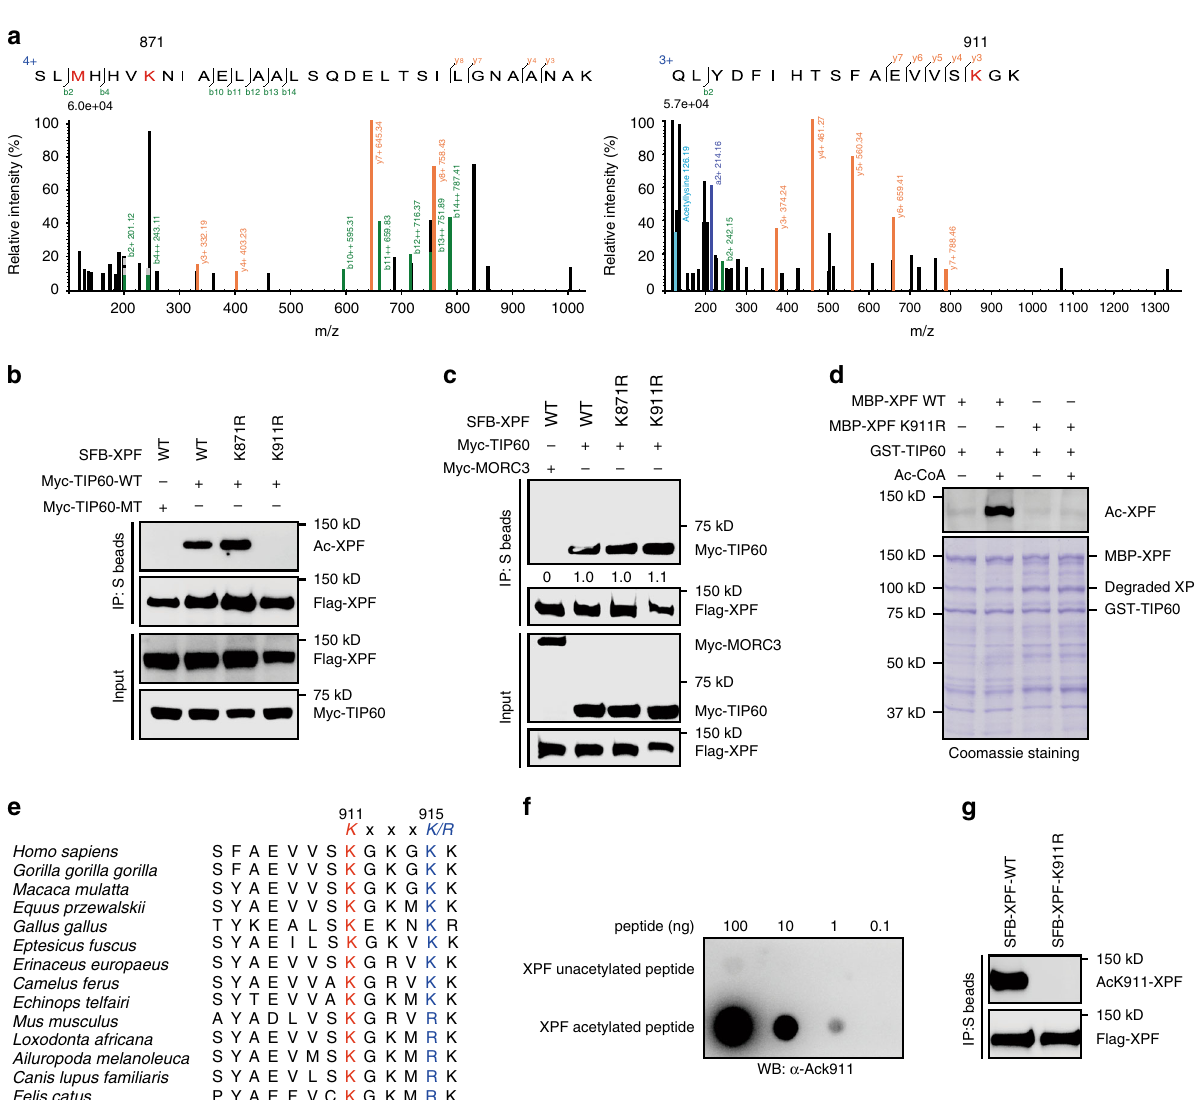
the mRNA levels of both XPF and ERCC1 (Supplementary Fig. 5E, F). We next determined whether acetylation of XPF is required for the damage-induced interaction of XPF and ERCC1. As shown in Fig. 6e, loss of Lys911 acetylation of XPF abolished the UV- induced XPF-ERCC1 interaction without affecting the constitutive interaction. In addition, the acetylation-mimic mutant K911Q interacted with ERCC1 to a greater extent than wild-type XPF in both the absence and presence of UV damage (Fig. 6e). In